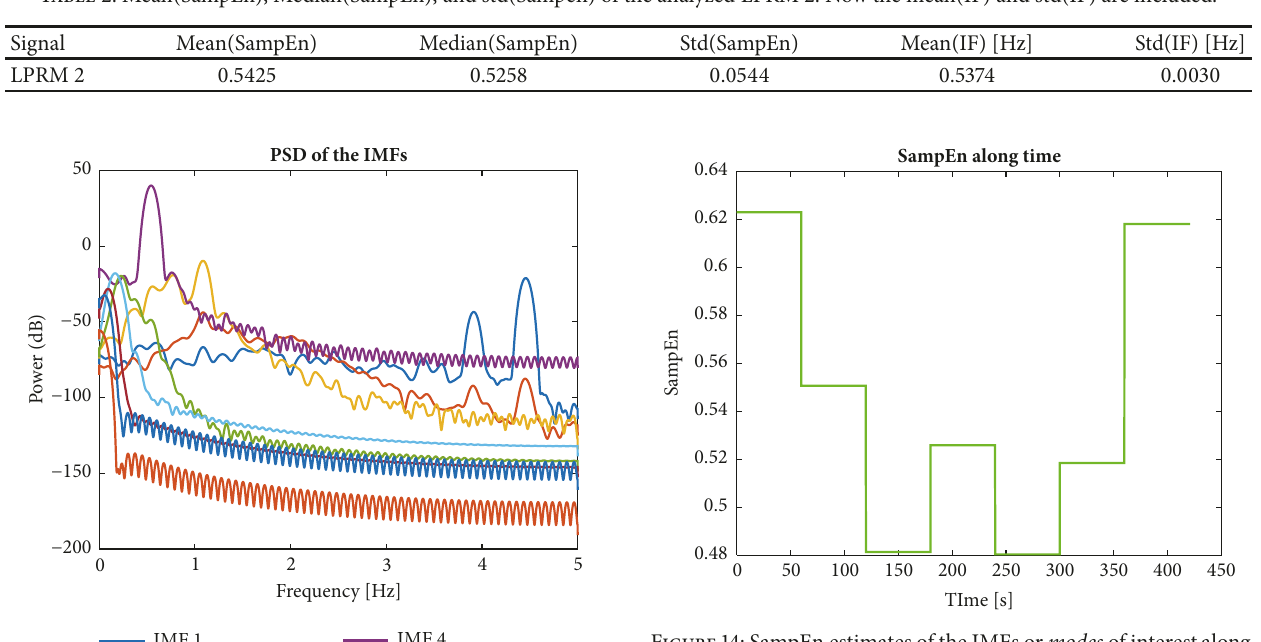
Figure 14: SampEn estimates of the IMFs or modes of interest along